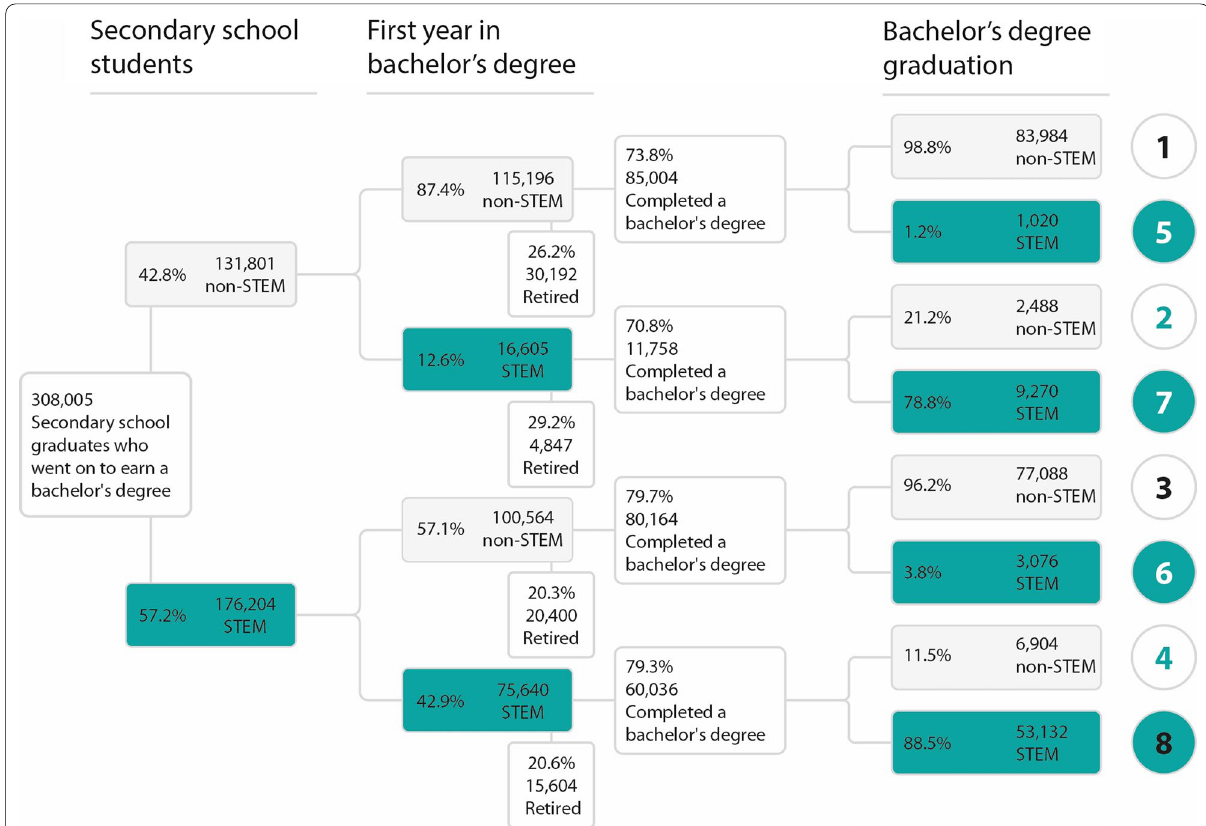
Fig. 4 Distribution of choice in STEM or non‑STEM field during significant periods in